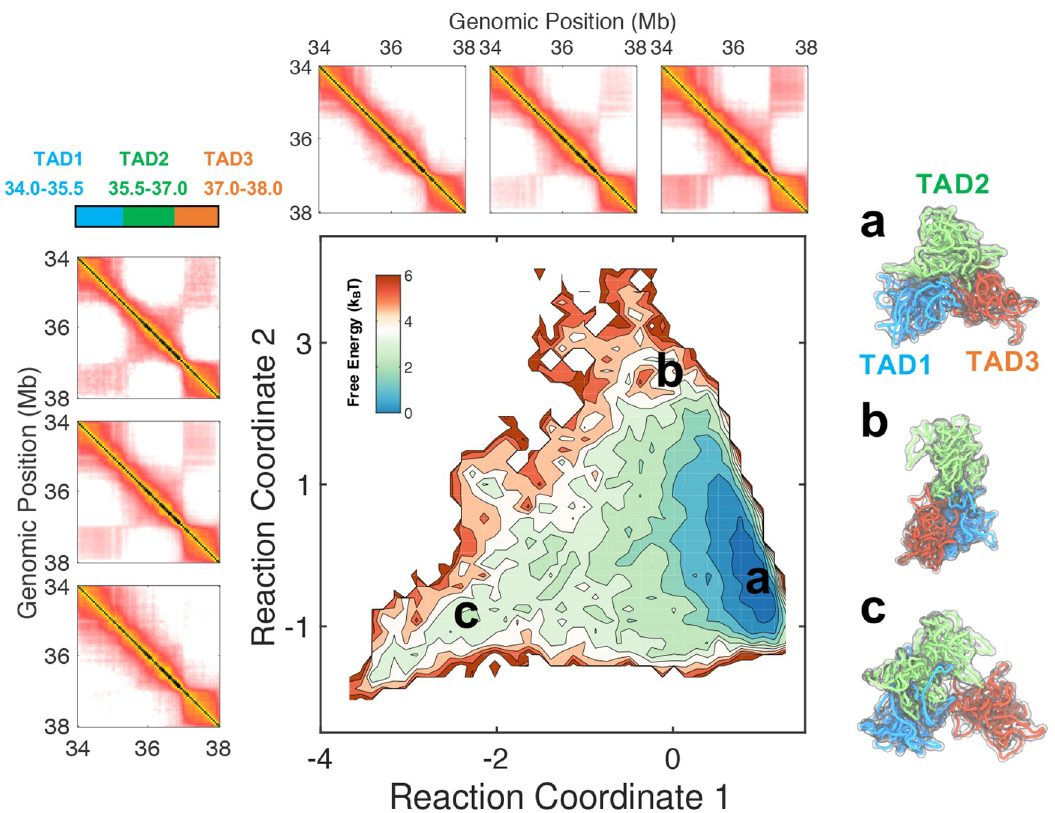
Fig 6. Structural characterization of topologically associating domains using the diffusion map technique. ( Center ) Free energy profile of TAD conformations projected onto two coordinates that describe the slowest collective motions. The ( Left ) and ( Top ) panels illustrate the change in contact maps along the two coordinates. ( Right ) Representative structures for the chromatin segment at various positions indicates in the central and bottom panel. The three contact maps for reaction coordinate 1 were calculated using chromatin structures that fall into the regions [ − 2.5, − 0.5), [ − 0.5, 0.5) and [0.5,1.5). The three regions used to determine the contact maps for reaction coordinate 2 are [ − 2.5, − 1.0), [ − 1.0, 1.5), and, [1.5,